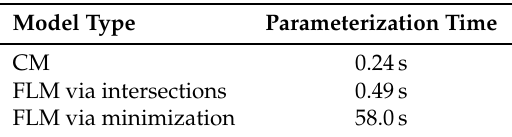
Table 2. Comparison of parameterization times.